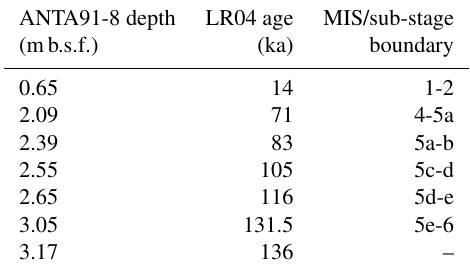
Table 3. Tie points for ANTA91-8 chronology. The MS record for ANTA91-8 is aligned to the LR04 benthic stack using the Analy- Series software (Paillard et al.,